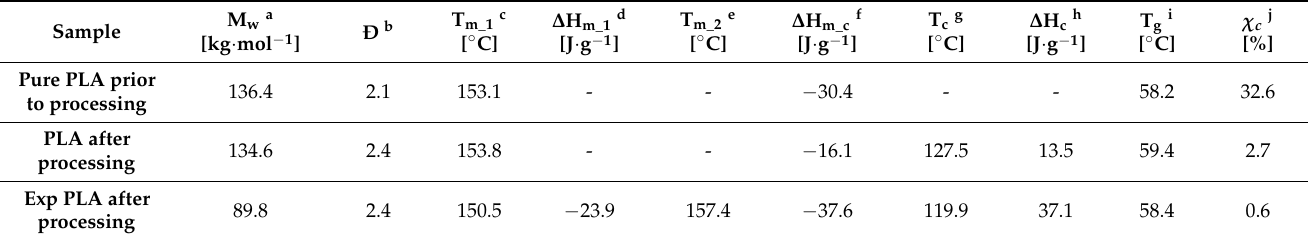
Table 1. Selected material properties of samples after preparation and before degradation